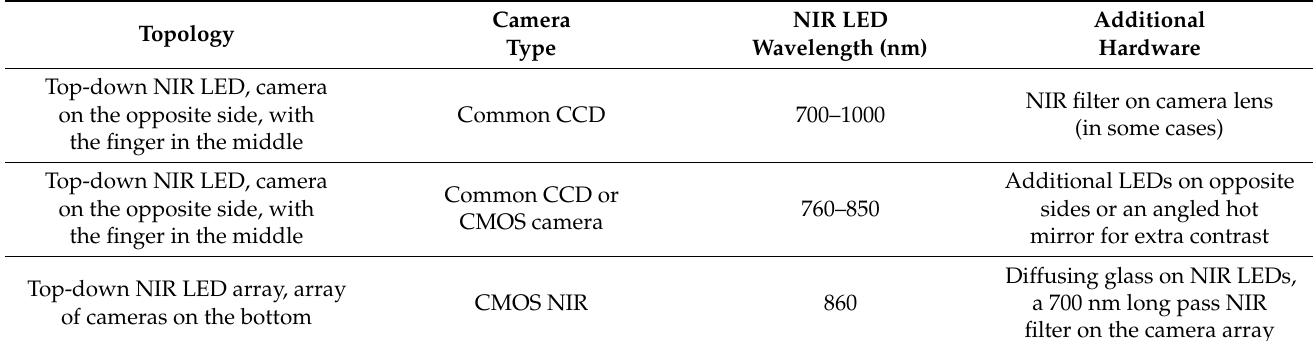
Table 9. Common hardware topologies and